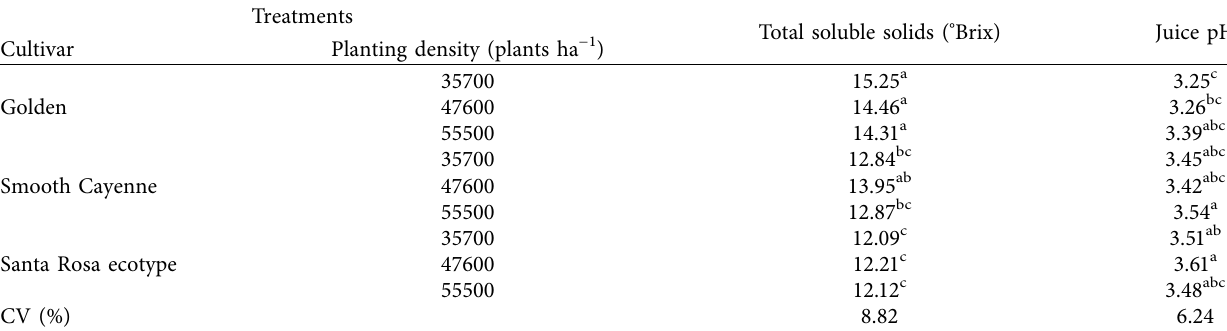
Means with different letters in the same column indicate significant differences (Tukey, p < 0 . 05). Table 4: Estimated yield of three pineapple cultivars grown at different planting densities.